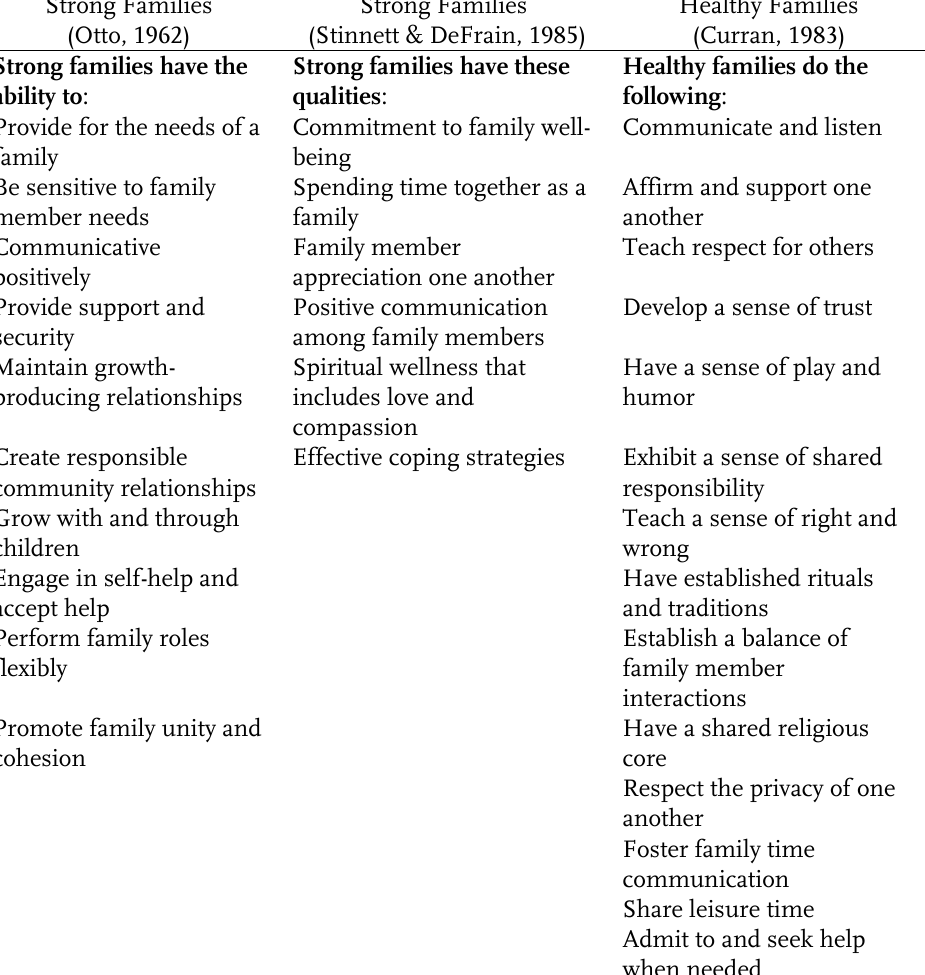
Table 1 : Types of family strengths identified by noted experts as the qualities of strong